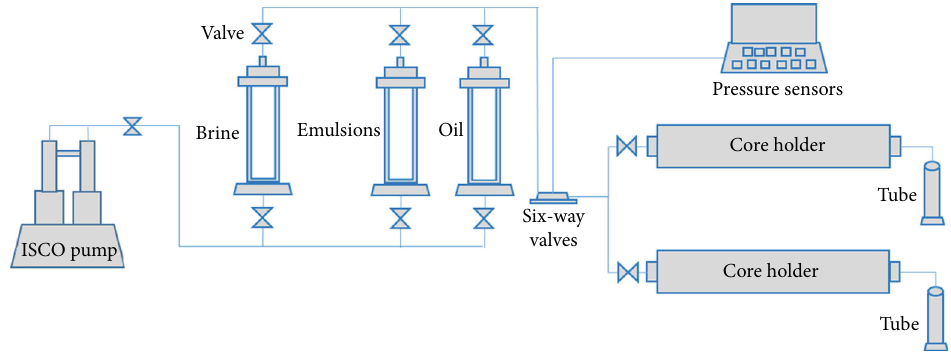
Figure 2: Schematic diagram of dual-core fl ooding experiments.